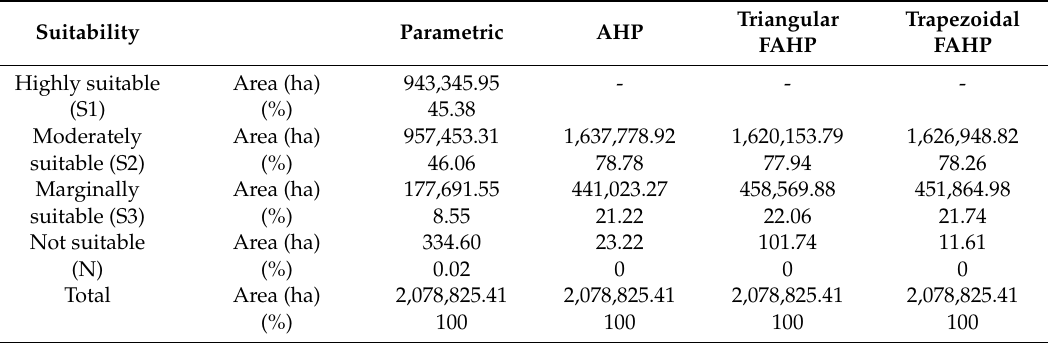
Table 10. Results for land suitability of all